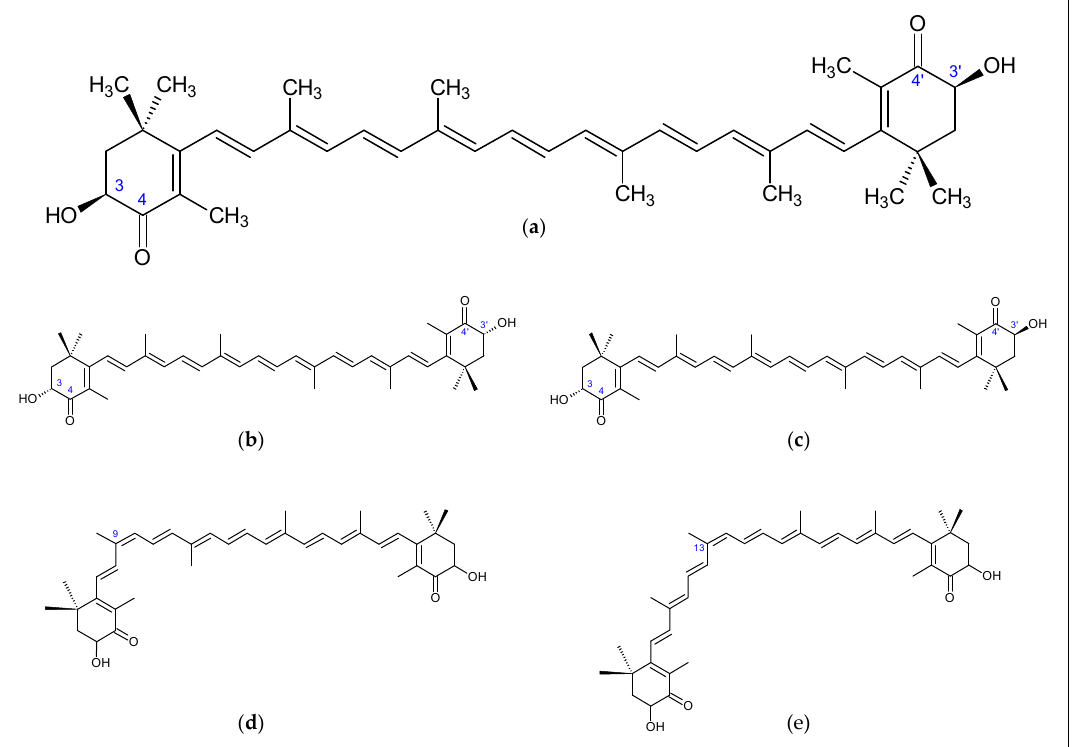
Figure 1. Molecular structures of some configurational and geometrical isomers of astaxanthin [17,18]. ( a ) (3S,3’S)-all- trans -astaxanthin; ( b ) (3R,3’R)-all- trans -astaxanthin; ( c ) (3R,3’S)-all- trans -astaxanthin; ( d ) 9- cis - astaxanthin; ( e ) 13- cis